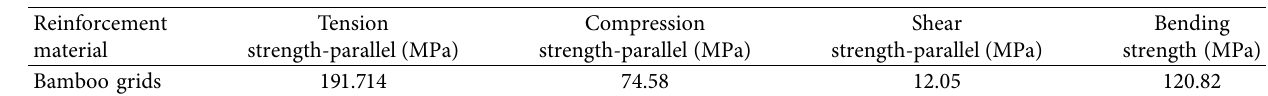
Table 1: Basic performance indicators of bamboo.